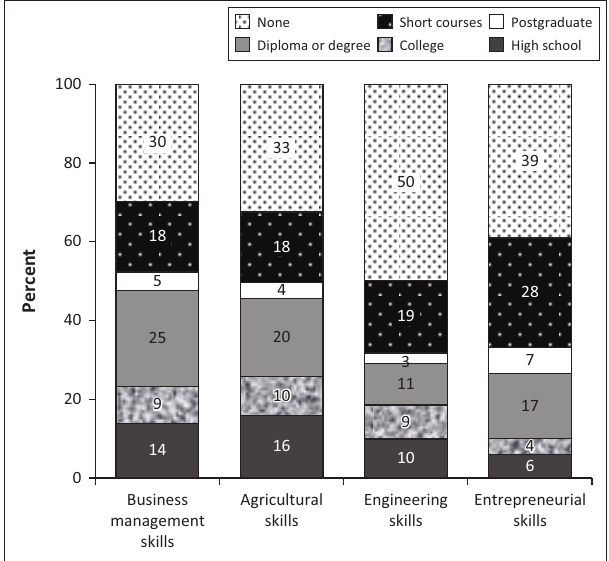
FIGURE 4: Level of education and skills acquired.